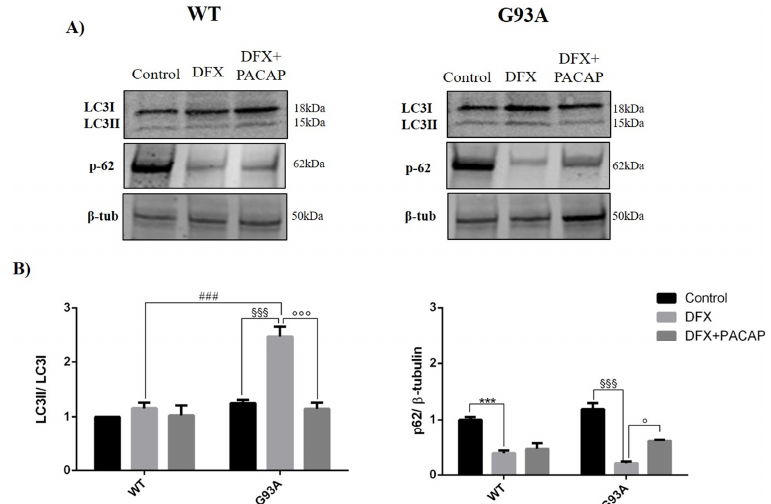
Figure 4. PACAP treatment modulates the light chain 3 (LC3) and p62 expression levels in the WT and G93A cells under hypoxia. ( A ) Representative immunoblots of the signals detected by the LC3I- LC3II and p62 antibodies on the WT and G93A cell homogenates cultured for 24 h in desferrioxamine mesylate salt (DFX) alone or in combination with PACAP (DFX + PACAP). ( B ) The bar graphs show